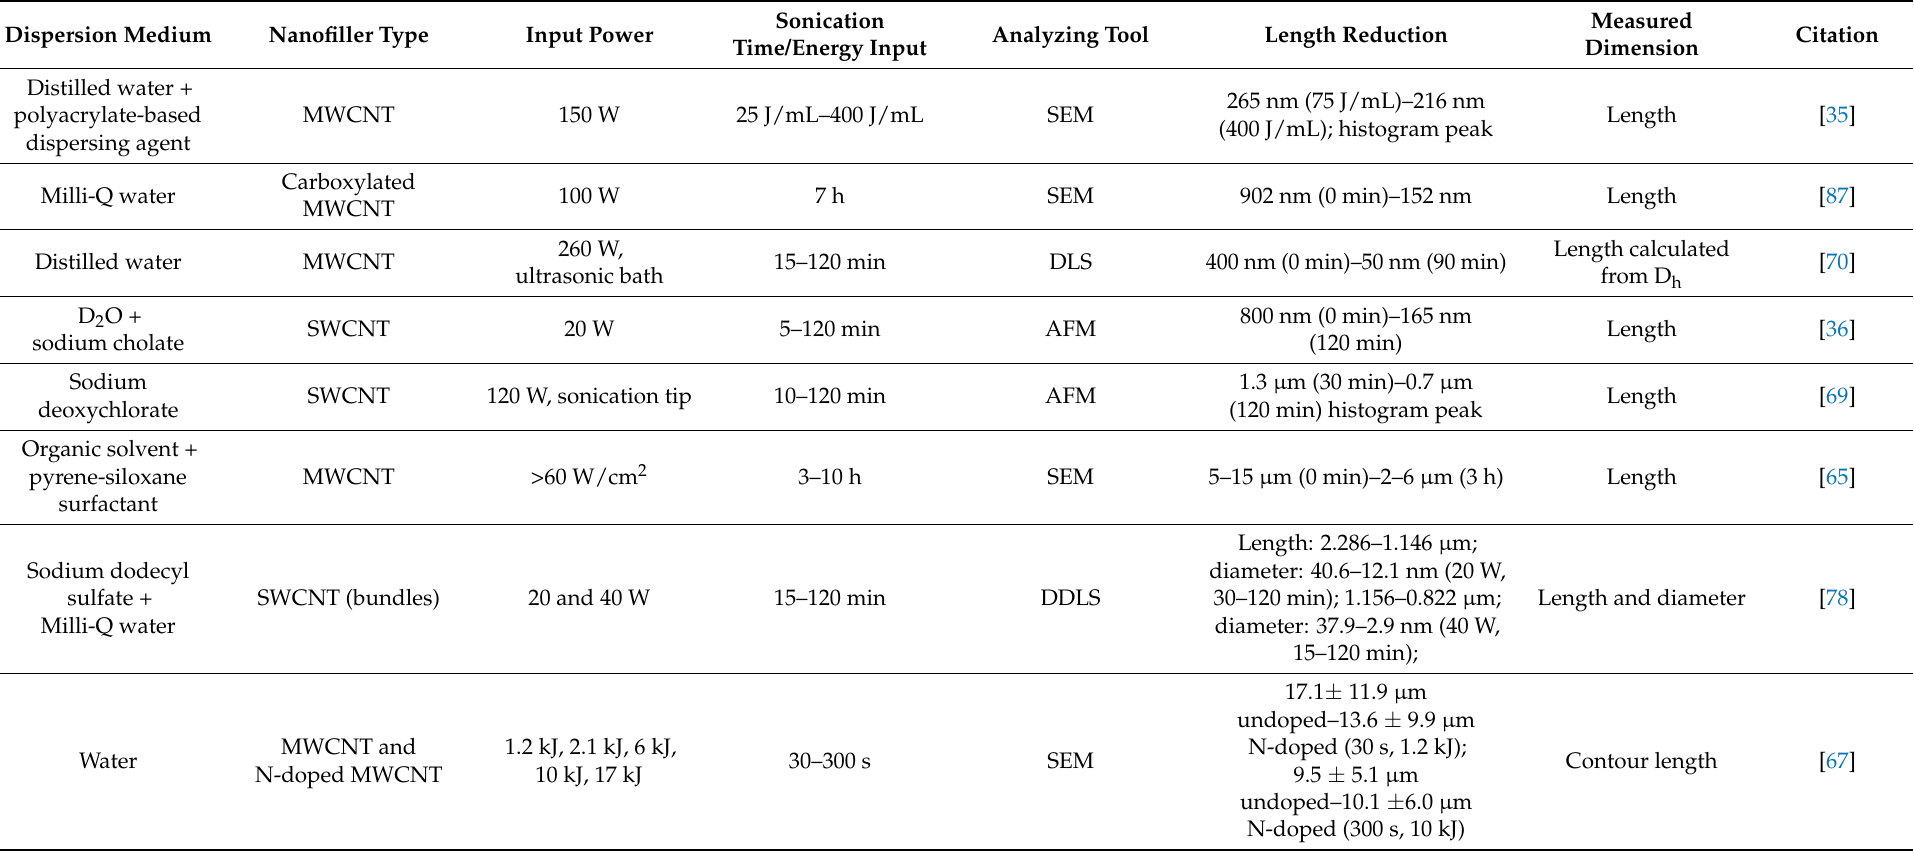
Table 2. Overview of reported length reduction of CNT due to sonication, indicating the solvent system, the type of CNT, sonication power, and energy applied, as well as determined damage, together with the respective